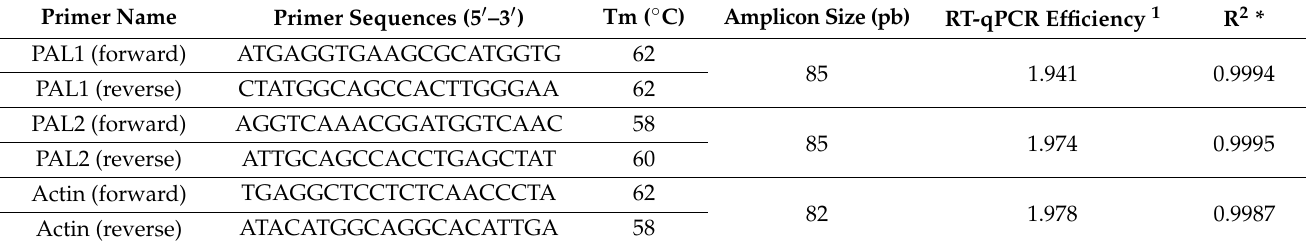
Table 2. Gene-specific primers and real-time amplification products for each